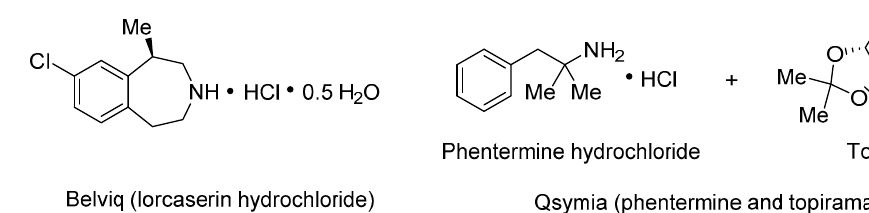
Figure 1. Molecular structure of Belviq and Qsymia.